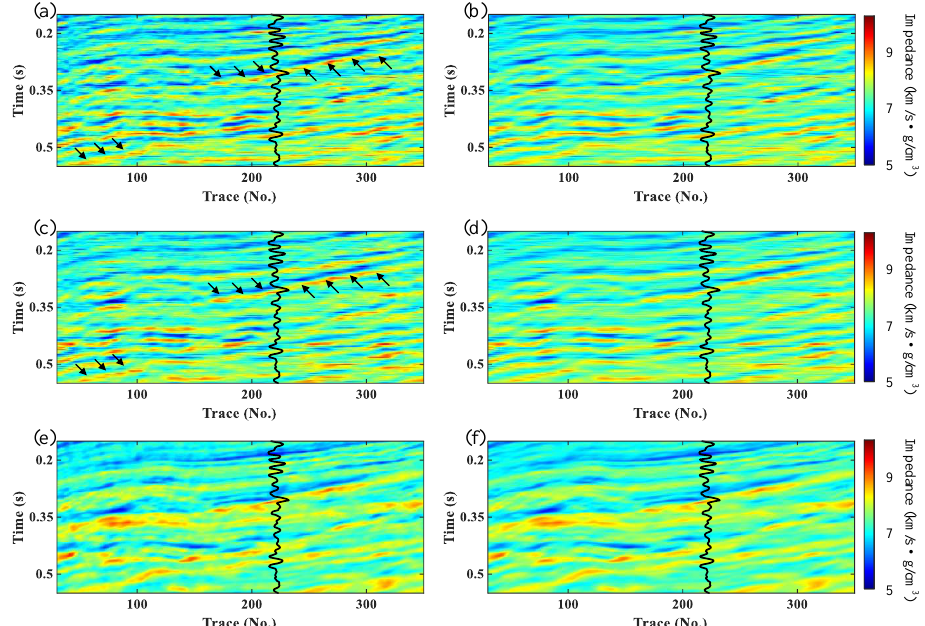
Figure 9. Multi-scale seismic data: ( a ) Low frequency data. ( b ) Medium frequency data. ( c ) High frequency data.